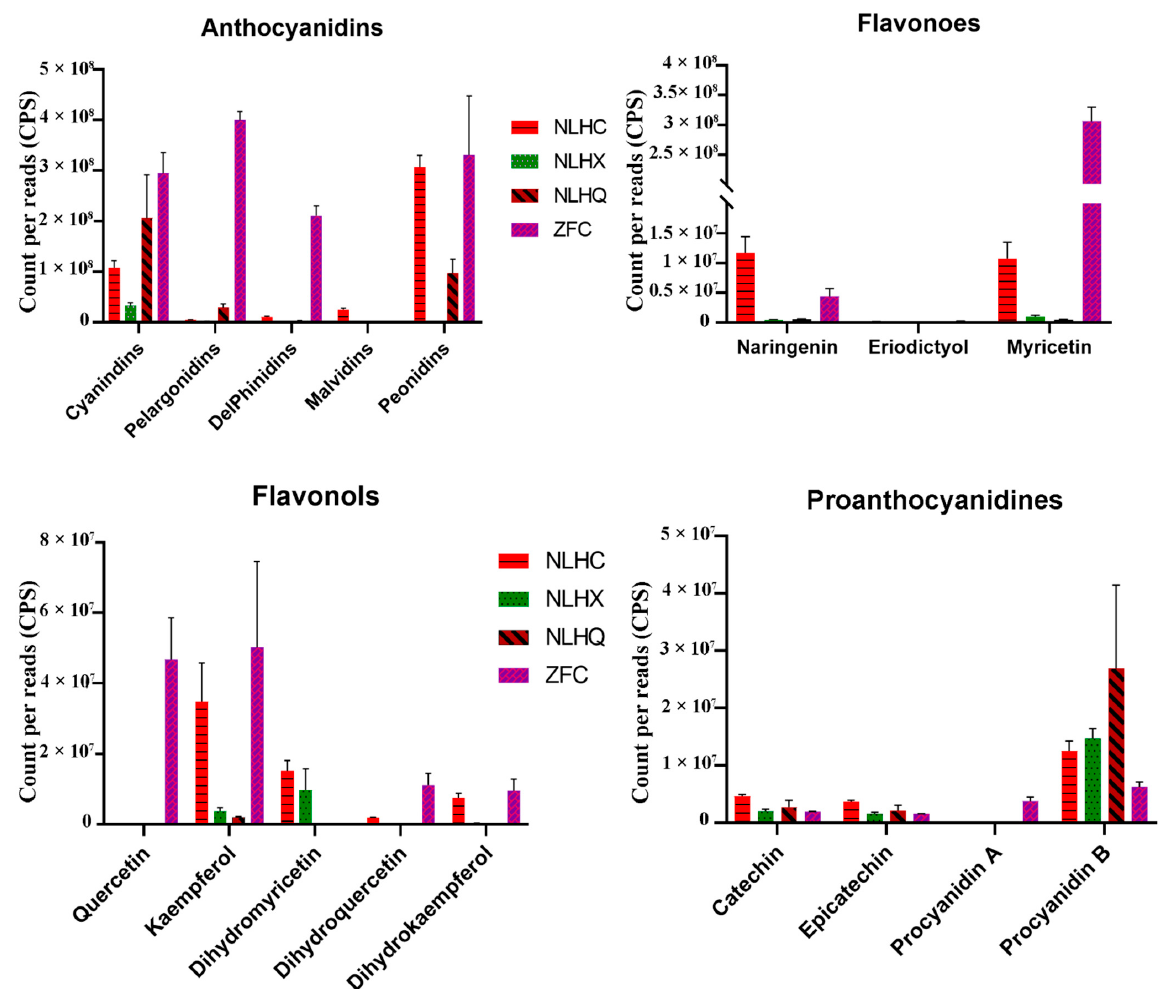
Figure 2. Flavonoid compositions of in three season leaves of L. formosana ‘Nanlinhong’ (NLH) and spring of L. formosana ‘Fuluzifeng’ (ZF). NLHC refers to the spring leaves of NLH with red color, NLHX refers to the summer leaves of NLH with green color, NLHQ refers to the summer leaves of NLH with dark red color, and ZFC refers to the spring leaves of ZF with purple color.